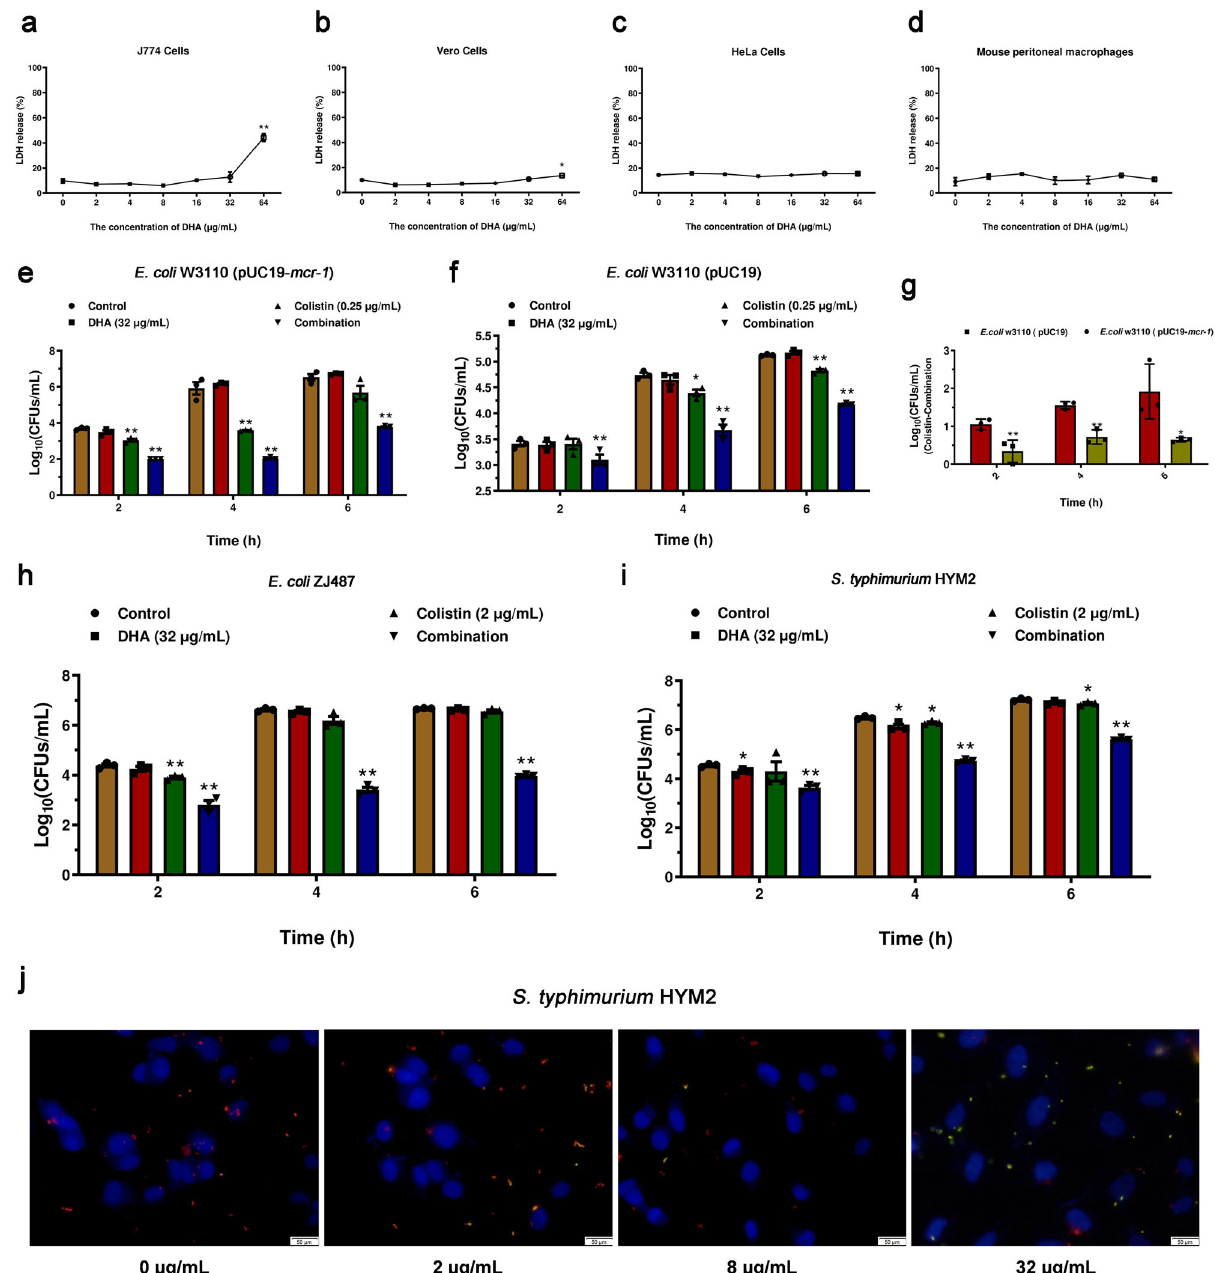
Fig. 5 DHA alone or in combination with colistin protects cells from preventing pathogen invasion. a – f , h , i LDH release by J774 cells ( a ), Vero cells ( b ), HeLa cells ( c ) and mouse peritoneal macrophages ( d ) co-cultured with various concentrations of DHA (0, 2 – 64 µ g/mL). The invasion of E. coli W3110 (pUC19- mcr-1 ) ( e ), E. coli W3110 (pUC19) ( f ) and E. coli ZJ487 ( h ) in Vero cells and S. typhimurium HYM2 ( i ) in HeLa cells was determined at 2 h, 4 h and 6 h ( n = 3). g The abilities between colistin and the combination to inhibit the invasion of E. coli W3110 (pUC19- mcr-1 ) and E. coli W3110 (pUC19) were calculated (Log 10 (The number of invasive bacteria after treatment with colistin)-Log 10 (The number of invasive bacteria after treatment with the combination)) at 2, 4, and 6 h. j Immuno fl uorescence microscopy detection (scale bar = 50 μ m) of DHA on S. typhimurium HYM2 invasion of HeLa cells showed that the number of intracellular bacteria was lower (red dyed) as the concentration of DHA increased. It showed that red-entered cells became less. * P < 0.05. ** P < As shown in Fig. 9b, administration of the low-dose (Fig. 9c, d). The medium-dose combination and low-dose combination (5 mg/kg + 20 mg/kg) and medium-dose combina- combination treatment led to signi fi cant remission of pathologi- tion (5 mg/kg + 40 mg/kg) improved the survival rate, with cal damage to organs in the abdomen, such as the liver and spleen survival increasing from 0% (solvent-treated controls) to 35.3% (Fig. 9e and Supplementary Fig. 7). Notably, the high-doses of and 58.8%, respectively. The mice treated with the medium-dose DHA injection had signi fi cant liver toxicity after multiple combination exhibited increased weight loss and morbidity under successive dosages. In addition, a reduction in CFU counts of sub-lethal dose infection of E. coli W3110 (pUC19- mcr-1 ) more than one order of magnitude was observed in the blood,